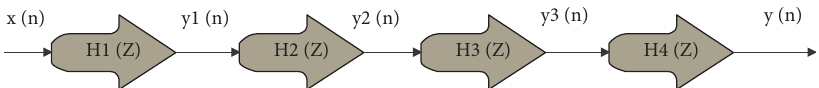
Figure 3: Mathematical solution process diagram of the output sequence of the gammatone filter.